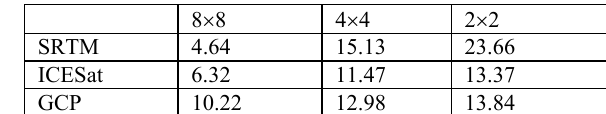
Table 1. Gaofen-3 DEM accuracy assessed using SRTM,